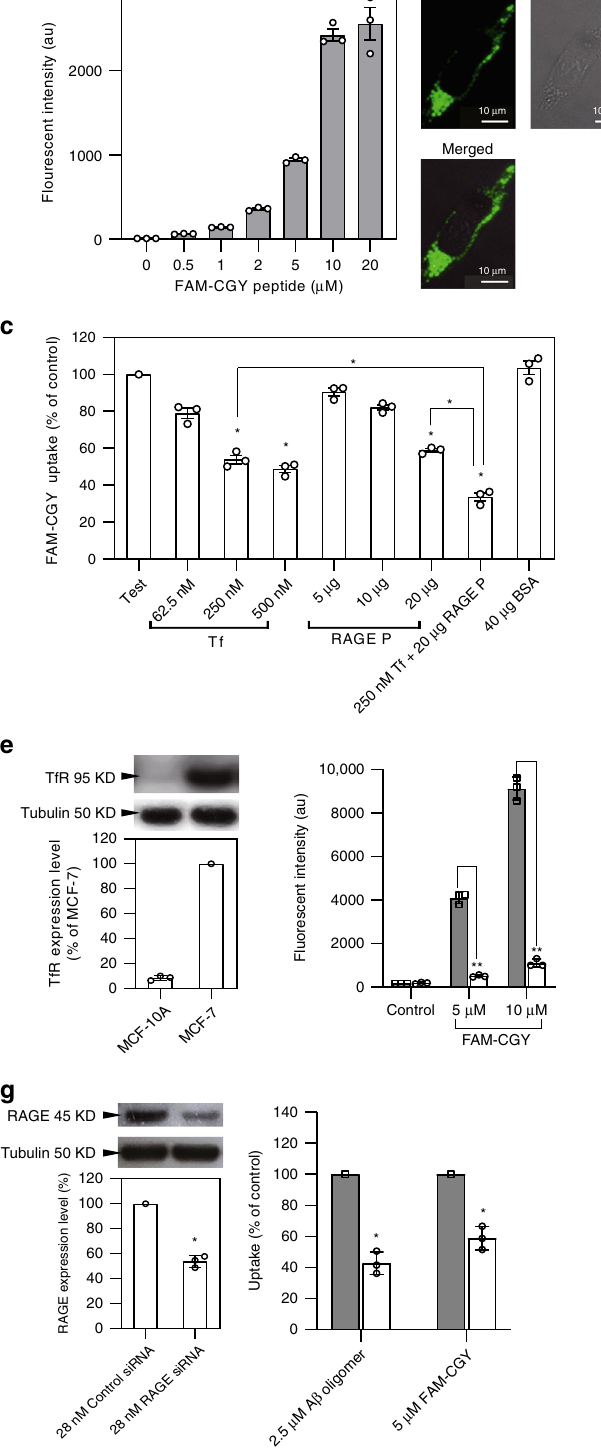
cell viability was >95% on RAGE down regulation as determined by the Trypan Blue exclusion test) reduced NLC uptake compared with their respective mock-silenced cells (Fig. 2g). Partial RAGE downregulation, also reduced tetramethylrhodamine (TAMRA)- labelled A β oligomer uptake by hCMEC/D3 cells, which is, at least, consistent with oligomeric A β 1 – 42 internalisation through endocytic processes and RAGE involvement in A β binding